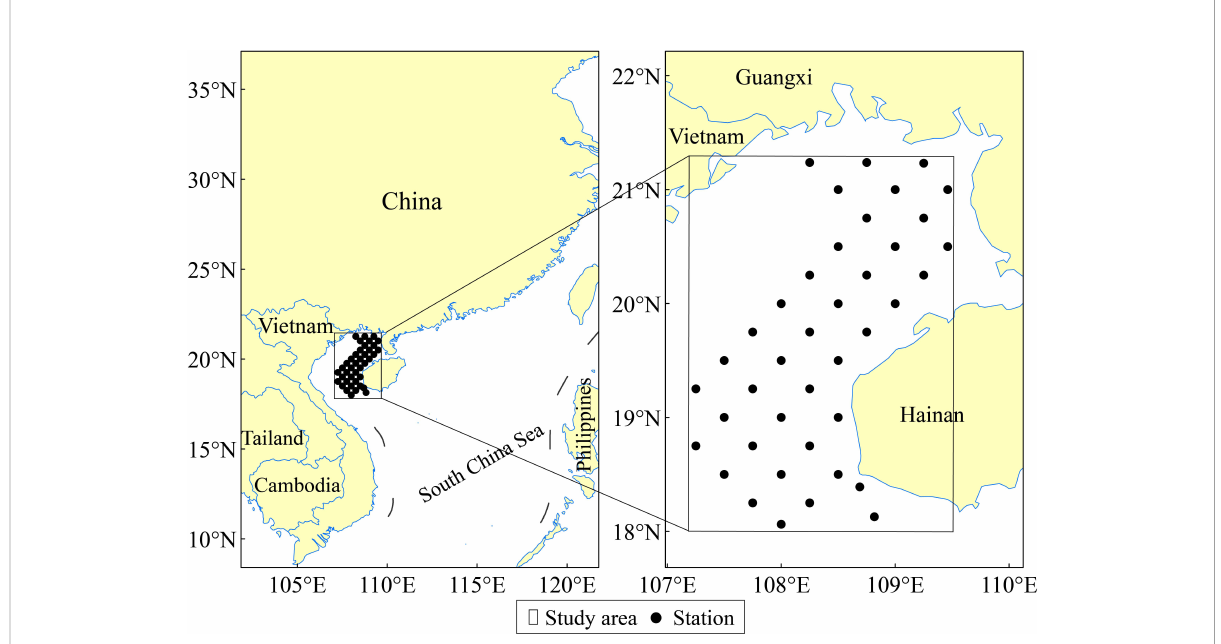
FIGURE 1 Maps showing the study area and stations where T. japonicus were sampled in the Beibu Gulf, South China